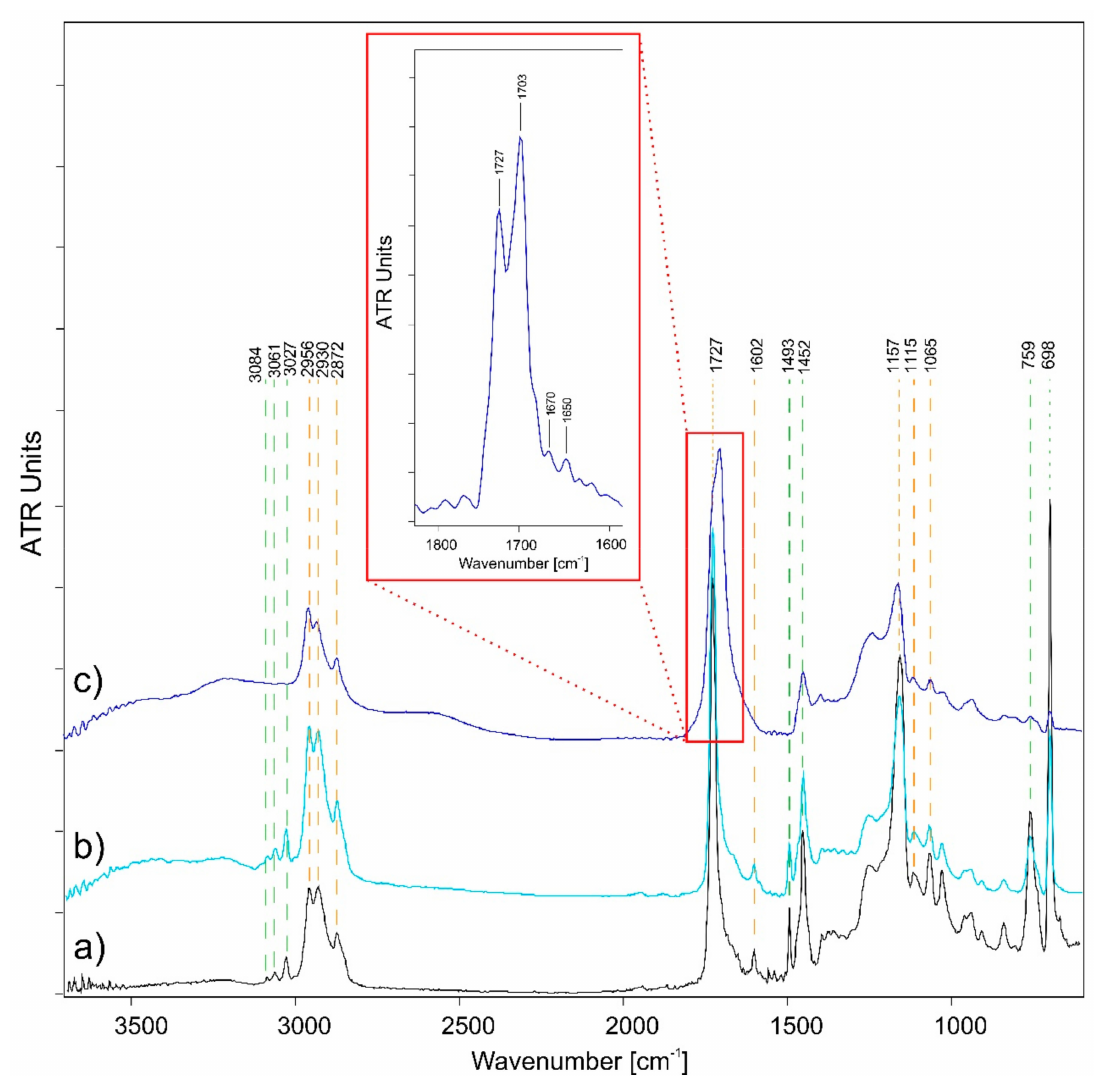
Figure 2. ATR-FTIR spectra comparison of pure styrene-acrylic films: ( a ) unaged (black), ( b ) 80% RH (light blue), and ( c ) 50% RH (blue) aged samples are